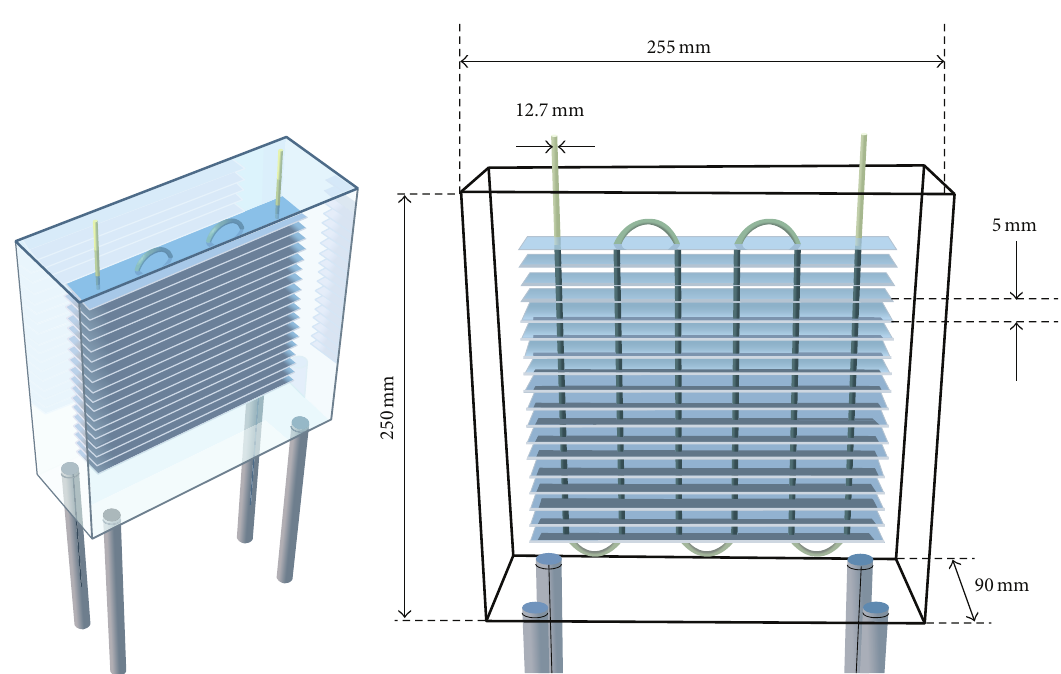
Figure 2: Schematic view of test section of finned-tube heat